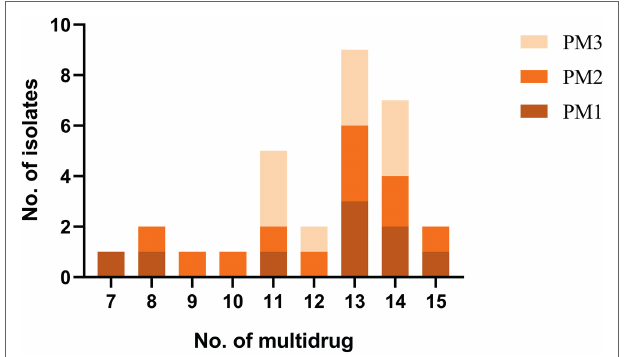
FIGURE 3 | MDR tests of P. mirabilis